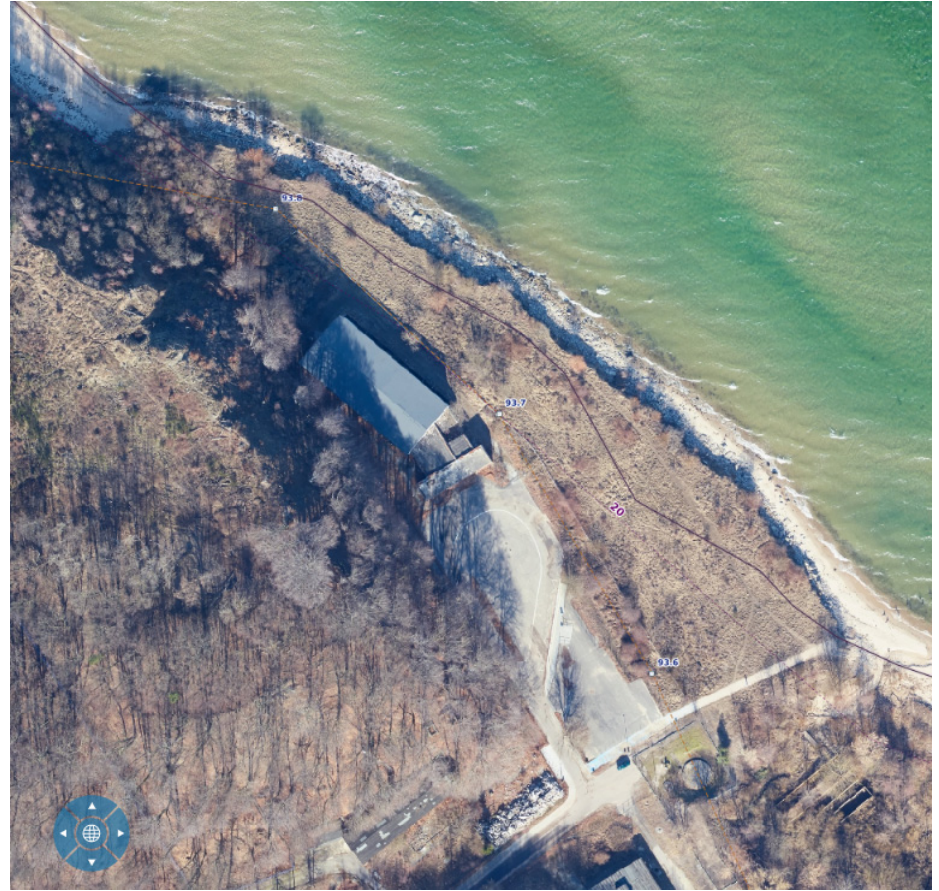
Figure 12. Shoreline (purple), protection borderline (dashed purple line) and requirements of the Coastal Protection Programme in the analysed shore section (https://sipam.gov.pl/geoportal (accessed on 16 June 2021)).